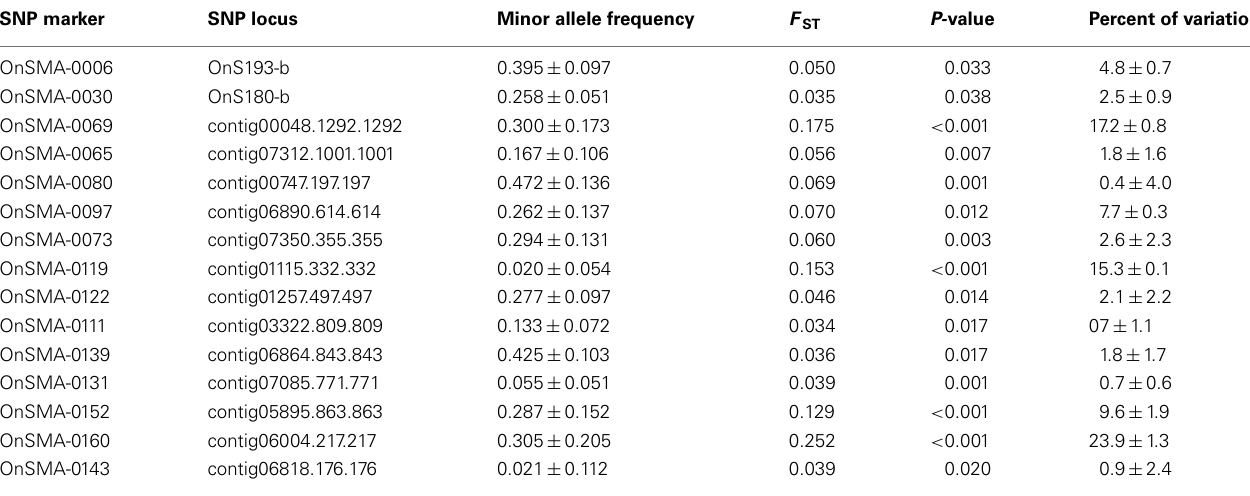
Table 3 | Single nucleotide polymorphism marker loci showing significant F ST differences.